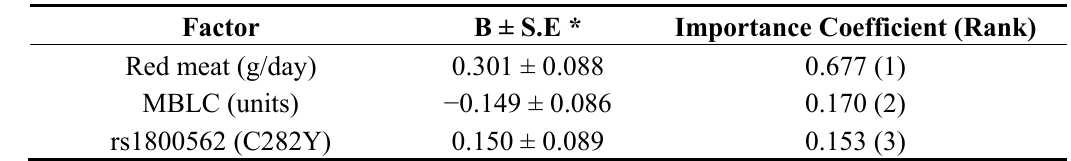
Table 5. Independent factors included in the categorical regression model that explained cluster belonging ( n = 142, R 2 = 0.142, p <